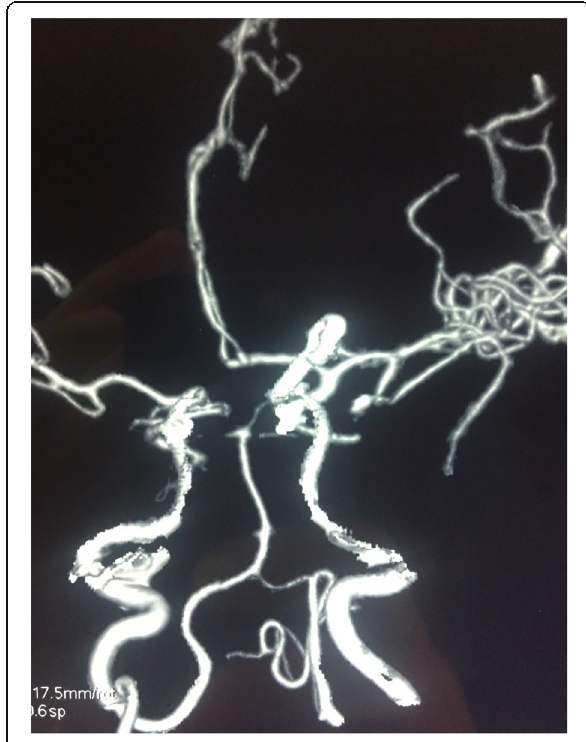
Fig. 5 Post-operative CT angio graphs showing the clip in situ with patent ICA and its